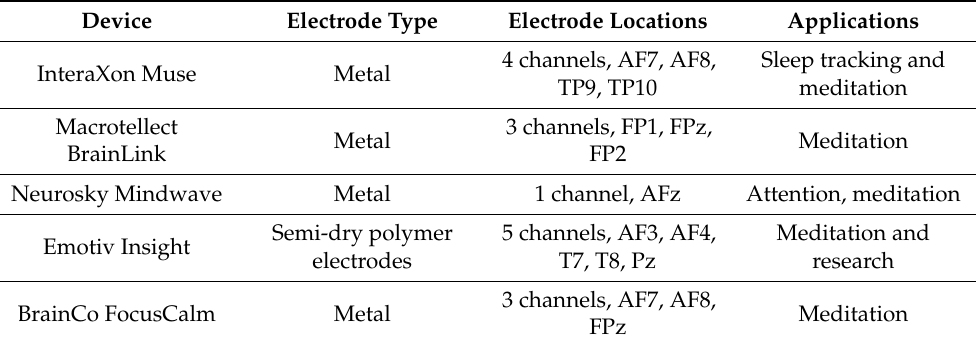
State of the art consumer devices which use head and forehead channels for EEG